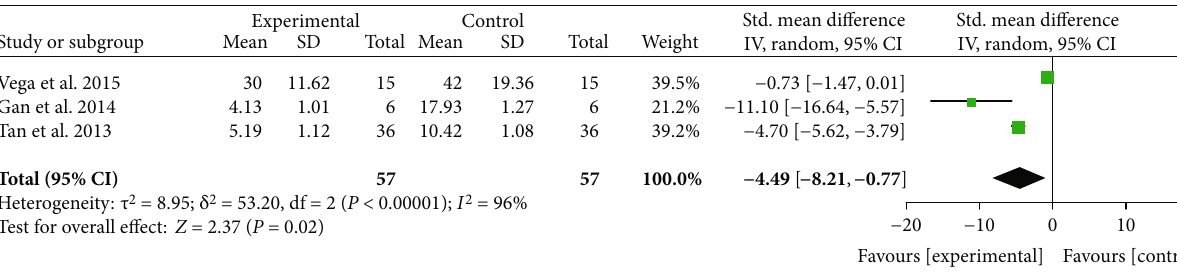
Figure 7: WOMAC physical function.